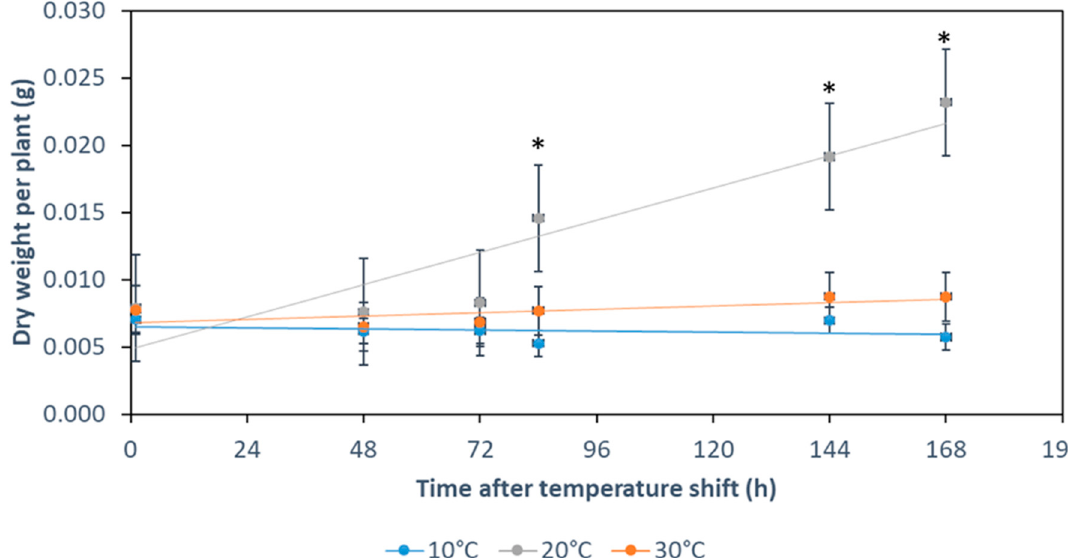
Figure 1. Arabidopsis Col-0 arrests biomass accumulation after shift to suboptimal temperatures. Plants were temperature shifted in the middle of the light phase at developmental stage 1.10, i.e., a rosette with 10 leaves with at least 1 mm in length, as defined by Boyes et al. [55]. Shift at 0 h from 20 ◦ C to 30 ◦ C (orange), to 10 ◦ C (blue), or continuous 20 ◦ C (grey). Note that control plants at 20 ◦ C continued to accumulate dry weight during the first 7 days. Plants submitted to suboptimal temperature, either 10 ◦ C or 30 ◦ C, did not accumulate dry weight in the same period. The dry weight differences at and following 84 h of temperature acclimation were significant (asterisks, t -test significance p < 0.05). Means were calculated based on three biological replicates at each time point. The error bars correspond to the maximum standard deviation encountered across time points (Table S1). Biological replicates were composed of three independent plants grown in hydroponic cultivation systems (Figure S1).